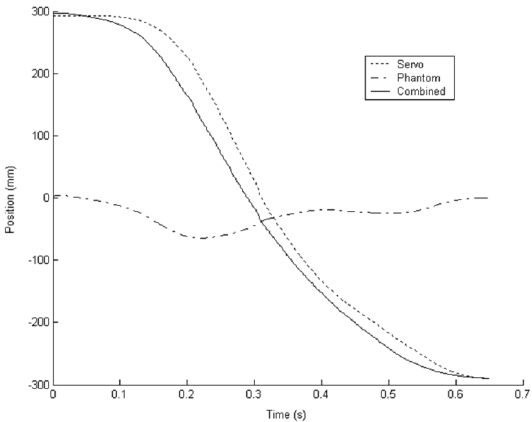
Figure 5. Averaged position profile for the reciprocal tapping task using the PD controller.